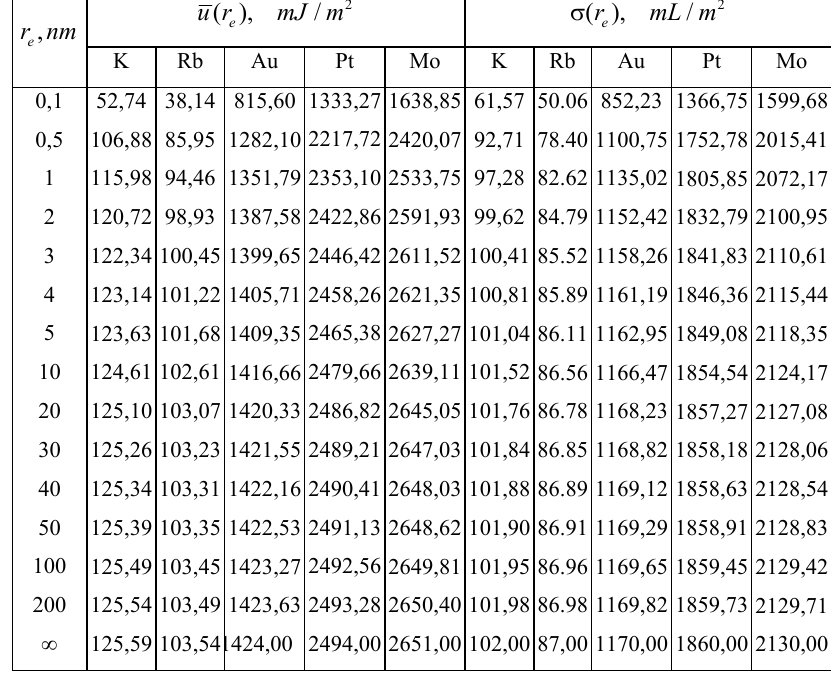
u r and of surface tension ( ) e